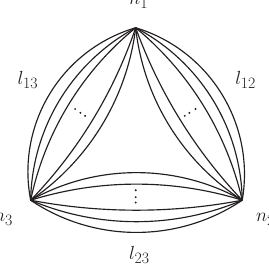
Figure 1. Wick contraction counting of a three point correlator. The vertices are labelled by i = 1,2,3, the order of the i -th vertex is n i , and there are l ij lines connecting two distinct vertices i and j